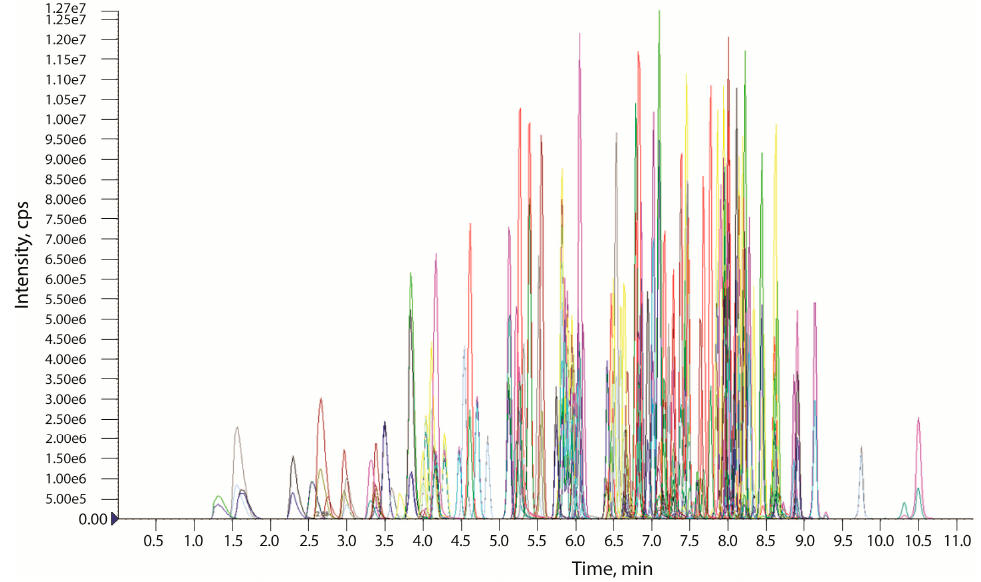
Figure 1. Extracted ion chromatogram of the working standard solution of 130 studied canna- binoids.